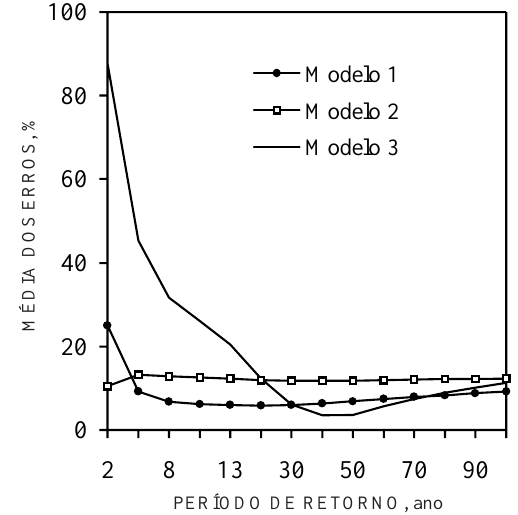
PERÍODO DE RETORNO, Figura 2. Média dos erros gerados por cada um dos modelos para todos os períodos de retorno e tempo de duração variando de 300 a 1.440 min.